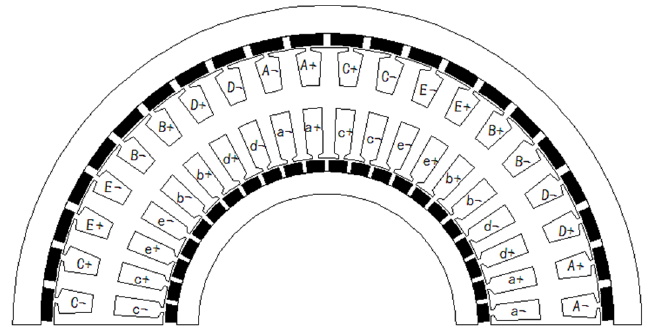
Figure 2. Coil connection of the half-model